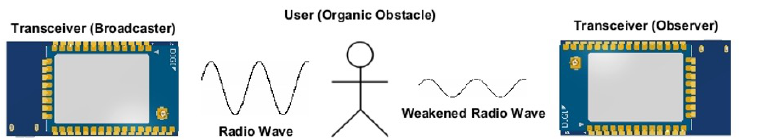
Figure 6. Symbolic representation of the phenomenon of partial blockage of EM waves when passing through the organic